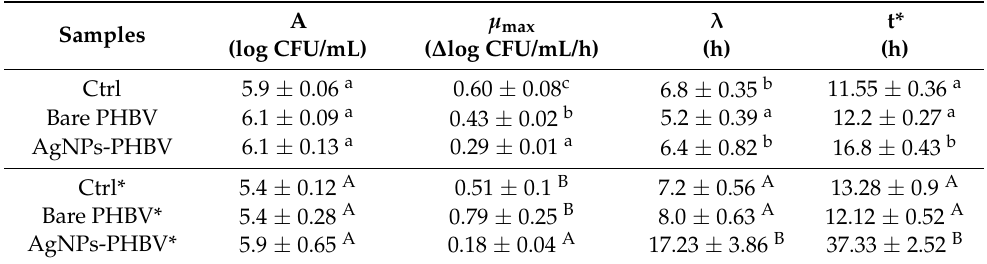
Table 2. Values of parameters calculated by fitting experimental data with Equation (2). A Samples (log